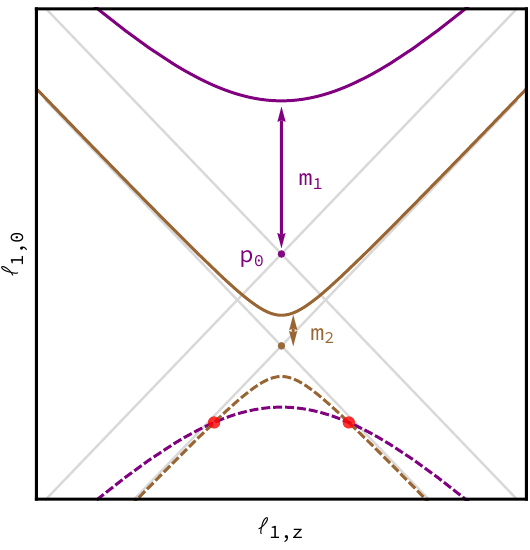
Figure 2 . Forward (solid) and backward (dashed) on-shell hyperboloids of the massive two-point function in eq. (2.8). For the kinematical con(cid:12)guration with 0 < p 0 < m 1 (cid:0) m 2 , the two forward on- shell hyperboloids do not intersect, but the two backward on-shell hyperboloids feature unphysical thresholds that cancel in the sum of individual dual contributions when the on-shell negative energy modes are also